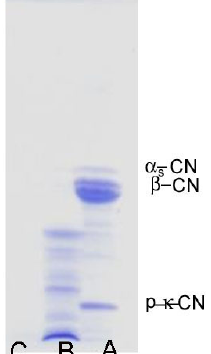
Figure 2. Sodium dodecyl sulfate–polyacrylamide gel electrophoresis (SDS-PAGE) of whole Sjenica sheep cheese before digestion ( A ), after pepsin digestion ( B ) and after pepsin + pancreatin digestion ( C